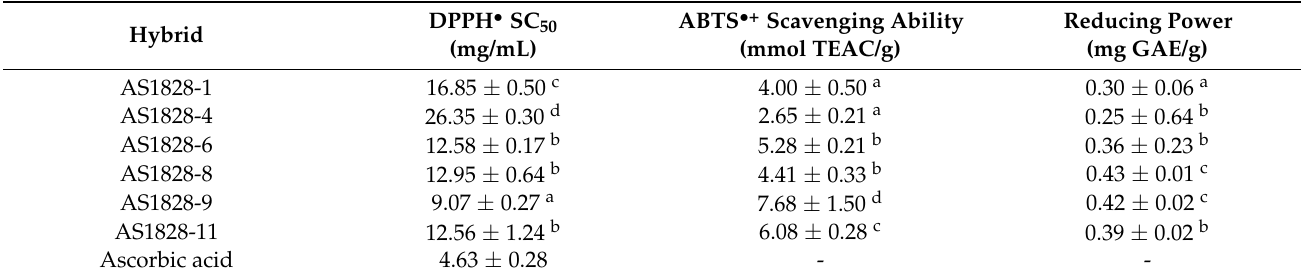
Results are mean values ± standard deviation (SD) of independent triplicate determinations. Along the same column, values having different superscript letters vary significantly ( p < 0.05). SC 50 , concentration of extract that scavenged 50% of DPPH • ; TEAC, trolox equivalent antioxidant capacity; GAE, gallic acid